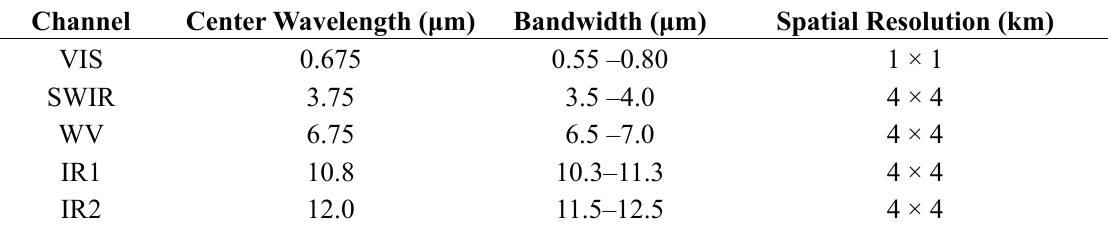
Table 1. Spectral channel characteristics of COMS